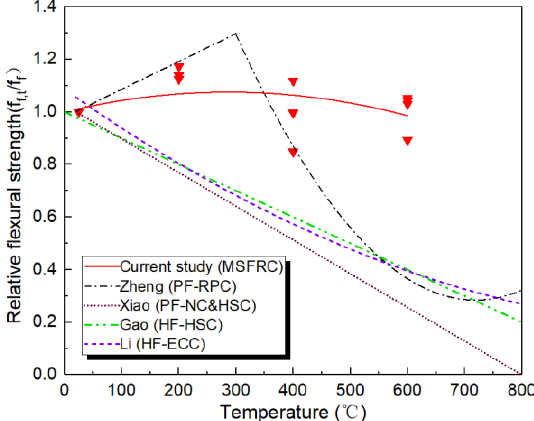
Figure 7. Computation model of flexural strength of heated MSFRC.